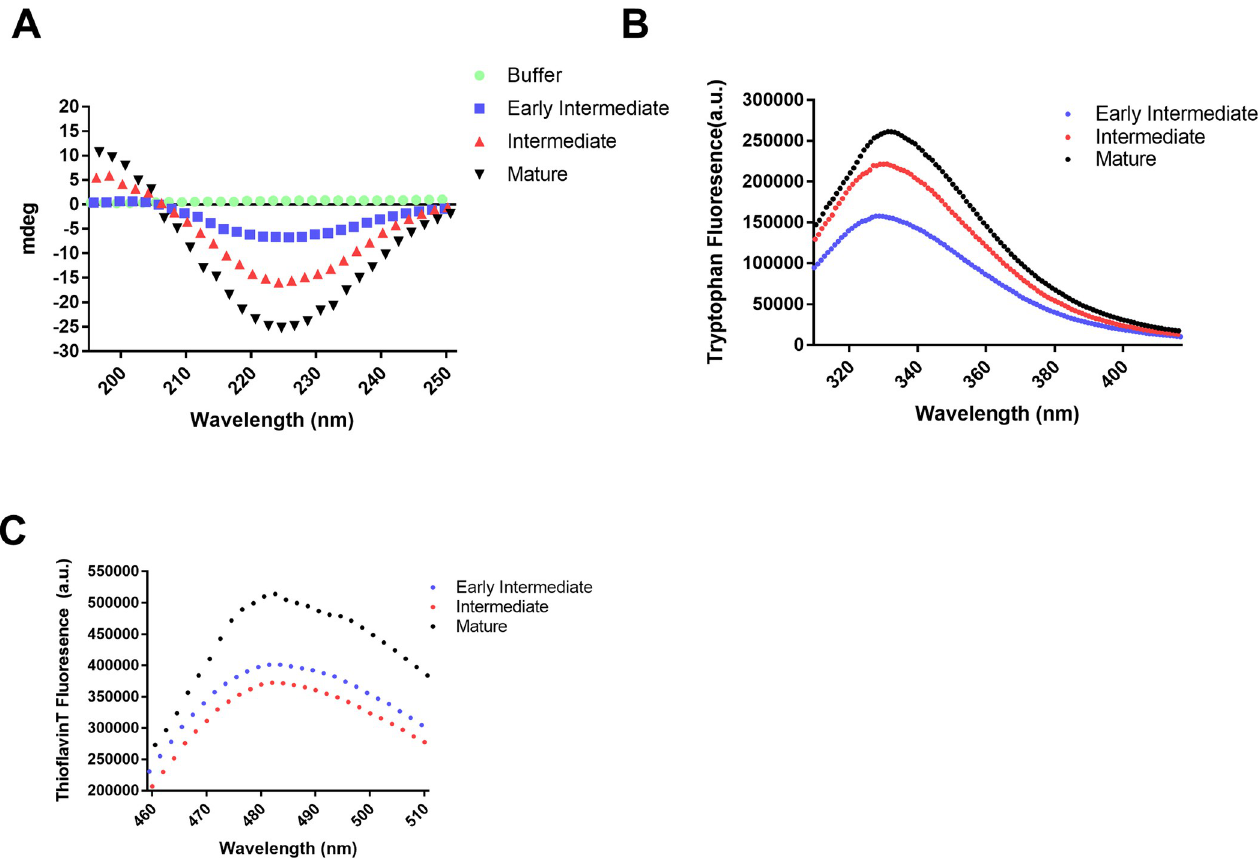
Fig 2. Characterization of curli structure over the course of fibril maturation. (A) UV circular dichroism spectra of mature (black triangles), intermediate (red triangles), and early intermediate curve (blue squares). The curve for buffer (green circles) is also shown. (B) Emission spectra of tryptophan in mature (black triangles), intermediate (red triangles), and early intermediate curve (blue squares) preparations. (C) ThT fluorescence in mature (black triangles), intermediate (red triangles), and early intermediate curve (blue squares)